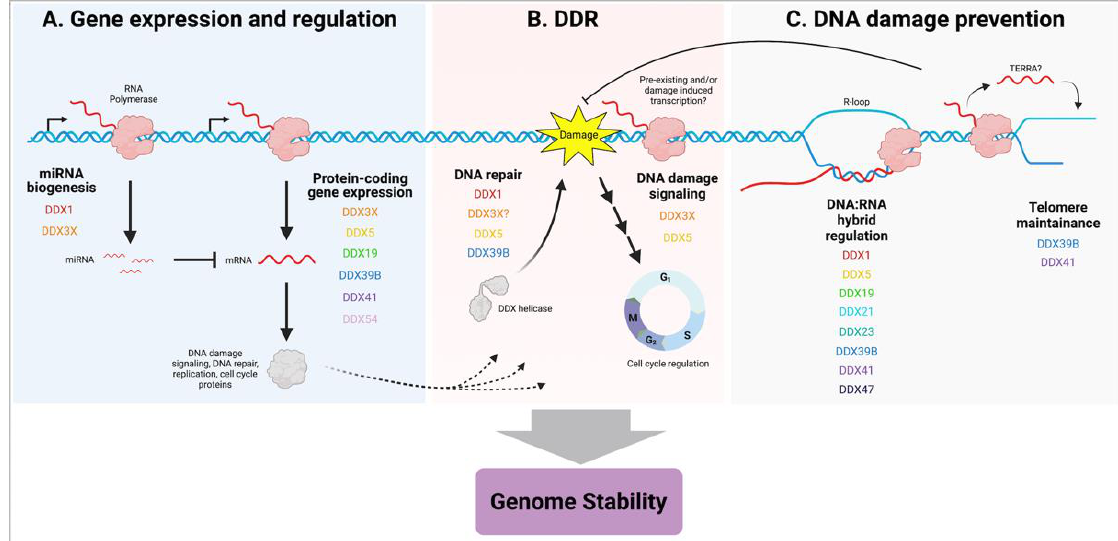
Figure 2. Summary of the themes regarding DDX RNA helicase involvement in genome stability. All DDX helicases mentioned are listed. ( A ) DDX RNA helicases promote the expression of genes important for genome stability (represented in the dotted lines) in addition to regulating their expression via microRNAs. ( B ) DDX RNA helicases are directly involved with the DDR either via DNA repair or the p53 DNA damage signaling axis, typically associated with the RNA metabolism aspects of these processes. ( C ) DDX helicases regulate complex nucleic acid species such as DNA:RNA hybrids and telomeric sequences, which are associated with DNA damage and genomic instability if left unprocessed. Created with BioRender.com accessed on 20 July 2021.